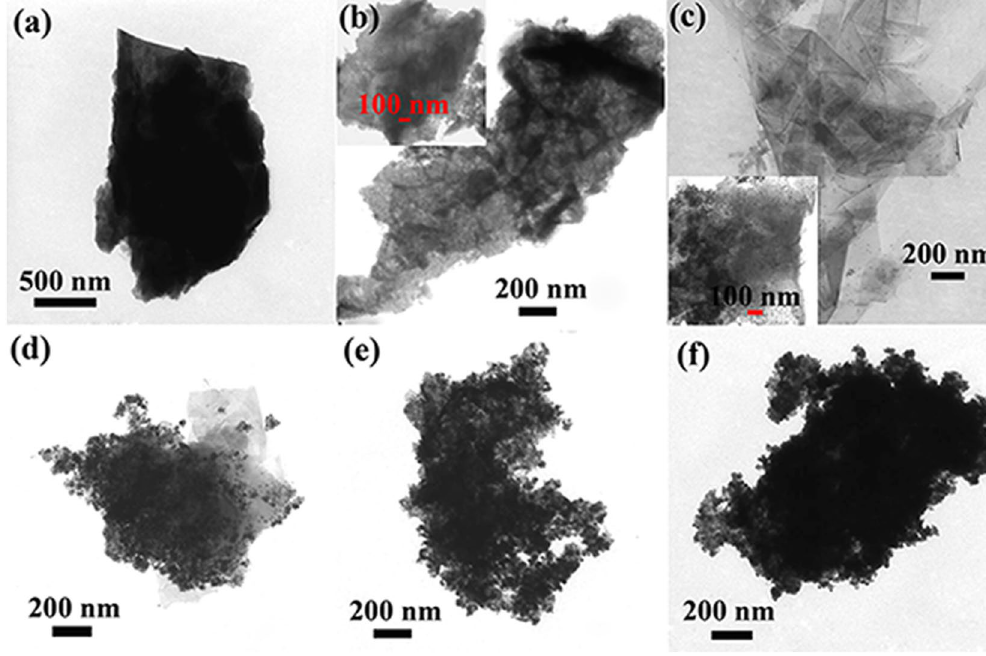
Figure 5. TEM images of ( a ) GP, ( b ) GS/PANI, ( c ) GS/PANI/Fe 3 O 4 -1, ( d ) GS/PANI/Fe 3 O 4 -2, ( e ) GS/PANI/ Fe